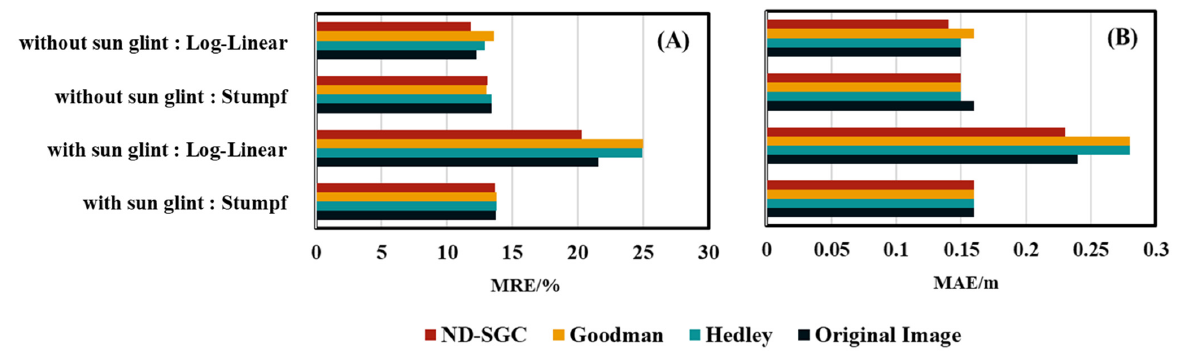
Figure 11. MRE, MAE of two bathymetric inversion models on the sun glint pixels and sun glint ‐ free pixels of Taiping Island. ( A ) MRE; ( B )